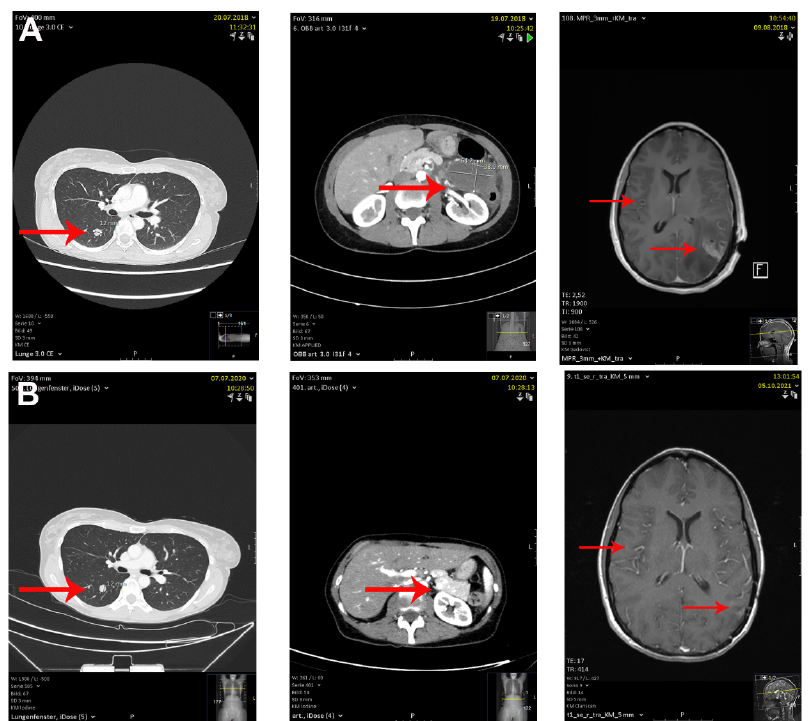
Figure 6. Results from MRI and CT scans of the 48-year-old female prior to the administration of combined checkpoint blockade in August 2018 ( A ) and results from the latest scans from July 2021 ( B ). Whereas pulmonary and cerebral metastasis are largely unchanged, a complete regression of gastrointestinal metastases was found over the course of immunotherapy. After interdisciplinary tumor board discussion and surgical resection of a large cere- bral metastasis followed by stereotactic radiation therapy with 30 Gy, cICB with ipili- mumab (3 mg/kg) plus nivolumab (1 mg/kg) q3w was initiated in August 2018 (for time-